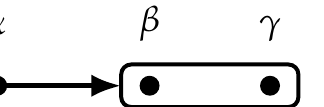
Figure 4. The relation B = { ( α , β ) , ( α , γ ) , ( β , β ) , ( β , γ ) , ( γ , β ) , ( γ , γ ) }